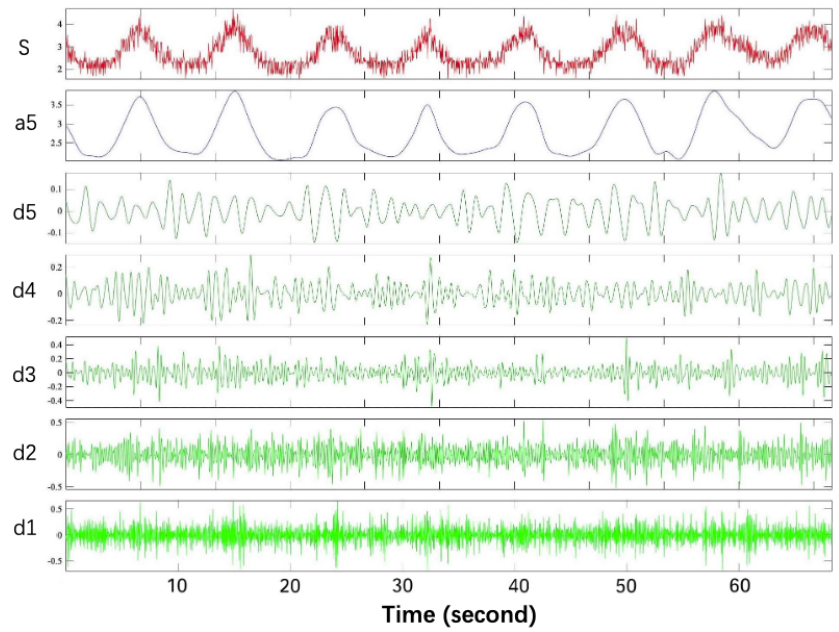
Figure 8. Wavelet domain